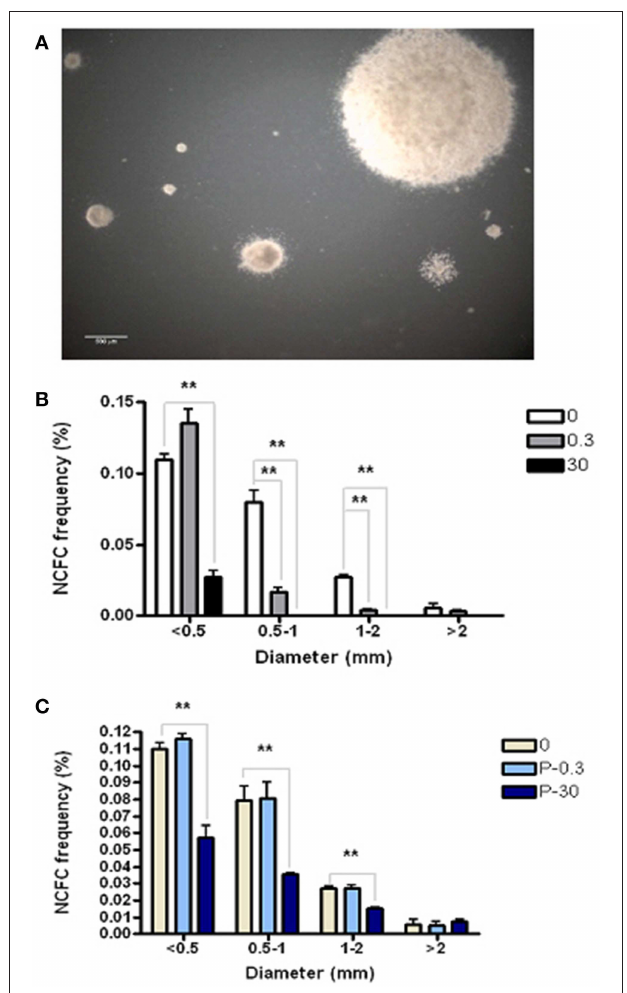
FIGURE 3 | AZT perturbs neural colony formation by both neural stem cells and neural progenitor cells. (A) Dissociated primary neurosphere cells were cultured in the Neural Colony-Forming Cell Assay in the presence of 0.3 or 30 µ M AZT. After 21 days in vitro , colonies were classified into one of four categories based upon diameter. (B) AZT at both concentrations causes a decrease in the size of neural colony formation by both stem cells ( ≥ 2mm) and progenitor cells ( < 2mm). (C) Pre-treatment of primary NS with 0.3 or 30 µ M AZT prior to dissociation into the NCFC Assay does not affect colony formation as severely as direct AZT application after dissociation. Here, 30 µ M AZT pre-treatment disturbs the formation of colonies derived from neural progenitor cells ( < 2mm), but does not decrease colonies derived from stem cells ( ≥ 2mm). P, pre-treatment; One-Way ANOVA, Dunnett’s Multiple Comparison Test of significance; N = 3 for all groups; ∗∗ p < 0 . 001 . Error bars represent standard deviation. NCFC frequency (%) = (number of colonies/total cells plated)